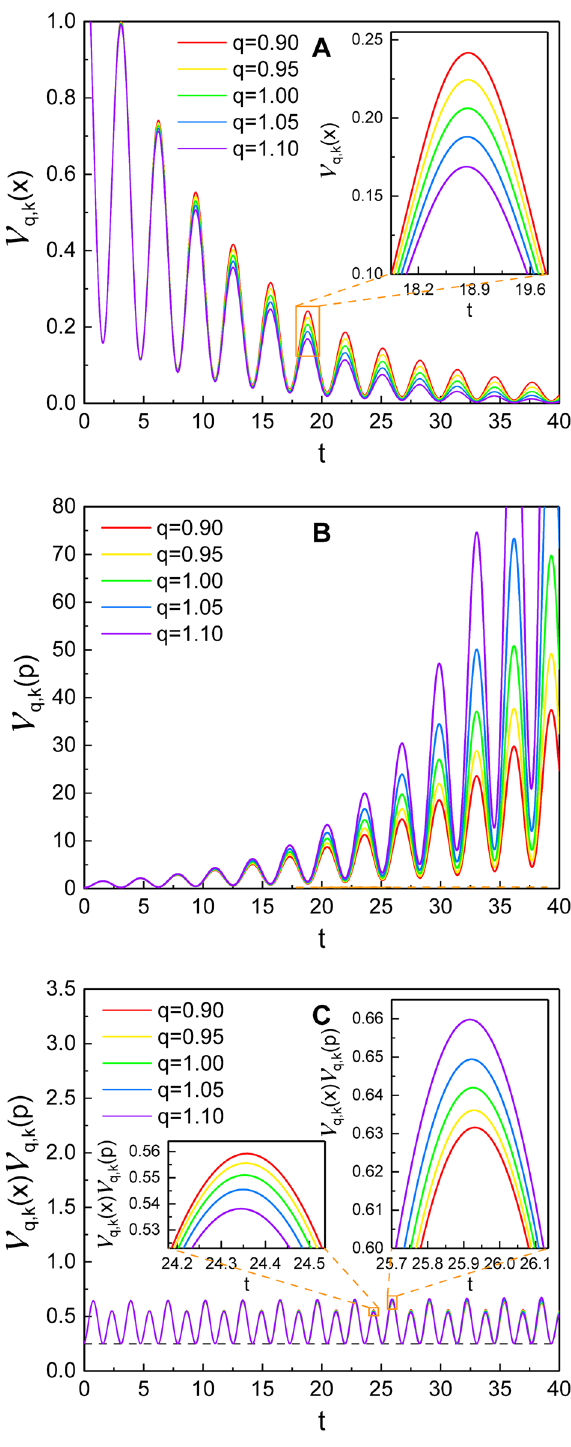
Figure 5. The variances, V q , k ( x ) ( A ) and V q , k ( p ) ( B ), and their product ( C ) as a function of t , which appear in Eqs. (54) and (55), for several different values of q . We used the approximation for ϕ( t ) , which is given in Eq. (56) (This convention will also be used in the subsequent figures). The insets in A and C are enlarged graphs for the designated parts. A reference line (dashed black line) on the bottom part of C is (cid:31) 2 / 4 , which is the minimum value allowed as the uncertainty product. We used ω 0.1 10 , k 1 / 4 , and s 0,1 s 0,2 c 1 c 2 = = = = =